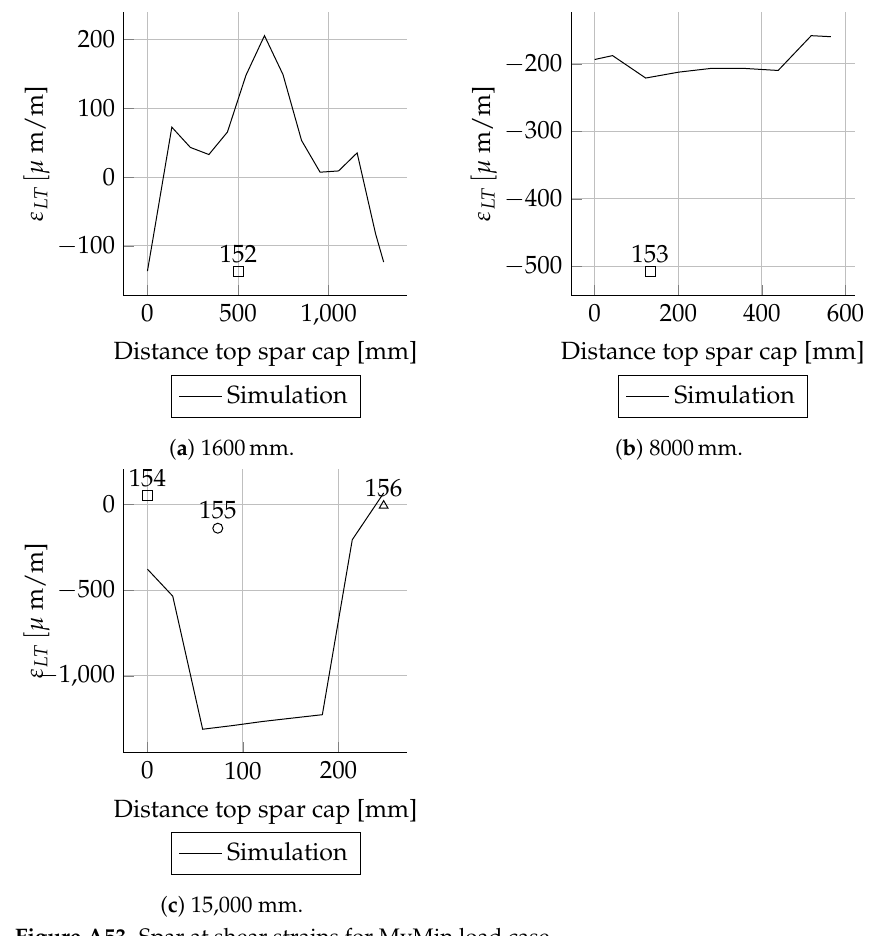
Figure A53. Spar at shear strains for MyMin load